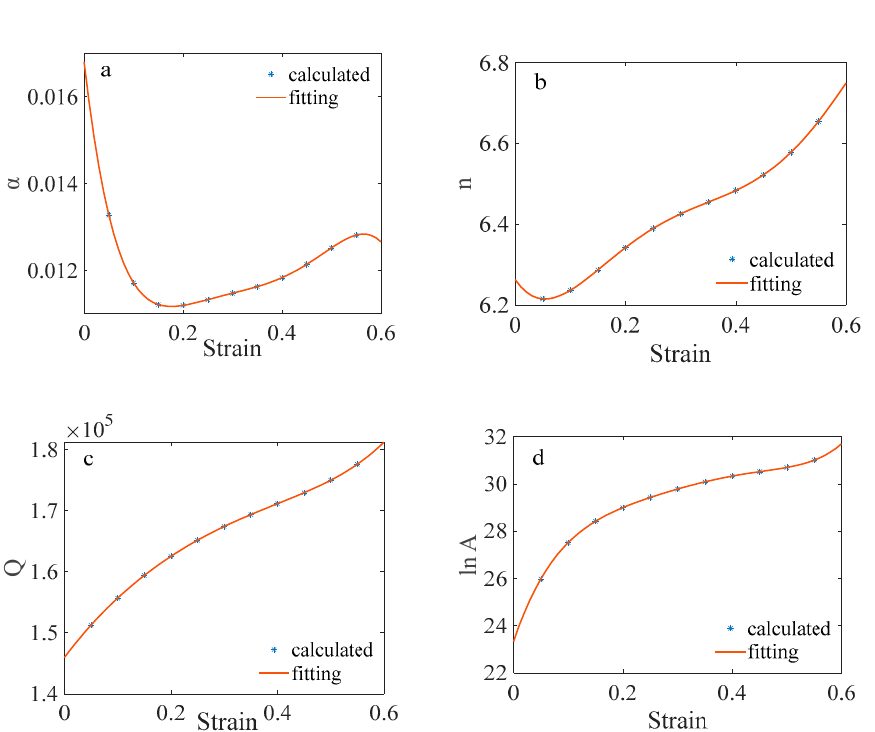
Figure 5. The influence of the strain rate on steady flow stress.